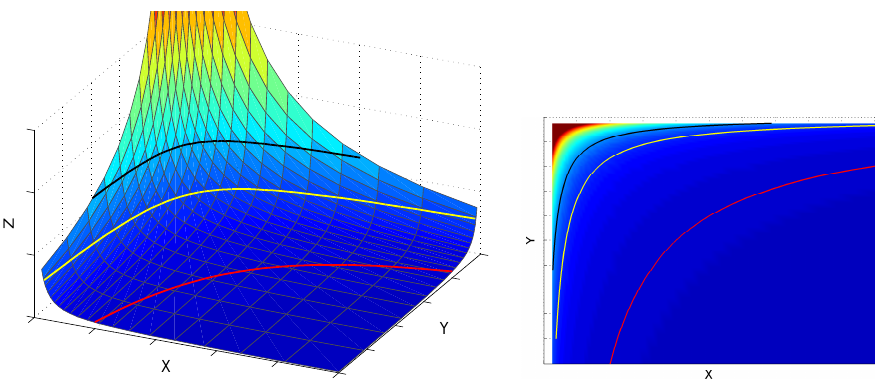
Figure 7. Cubic surface x · y · z = K ( left ) and its projection in the XY plane ( right ) including some horizontal